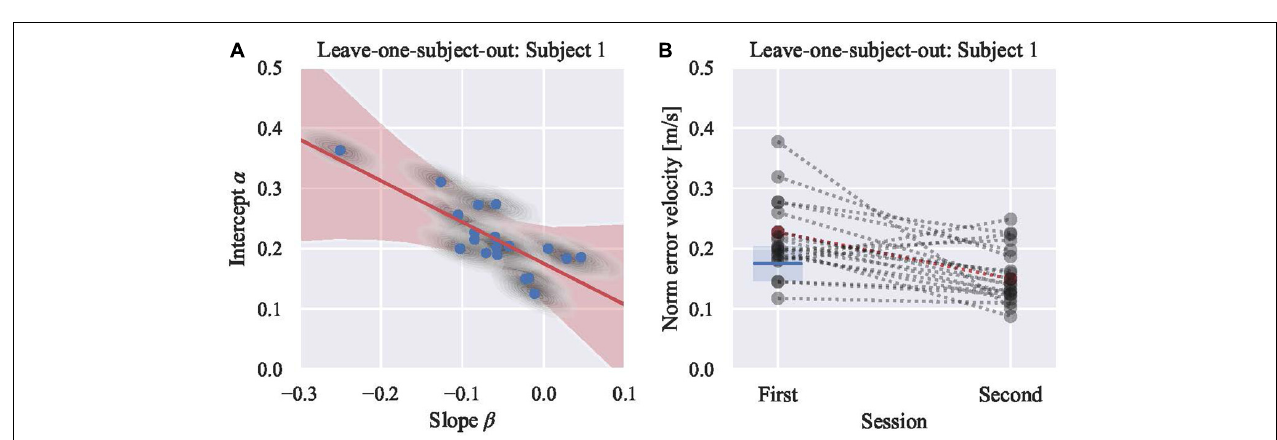
FIGURE 4 | (A) Posterior predictive plot of model 4 using 19 participants’ absolute position errors (leaving subject 1). Each gray shaded area represents multiple samples from the posterior [the intercepts ( α ) and the slopes ( β )] of each subject, and each blue circle shows the average of each area. Red shaded area represents regression lines for all samples, and red line shows their average. The boundary ( γ , the intercept of the red line) is 0.019 m with the credible interval (94%) from 0.017 to 0.021 m. (B) Visualization of classifying results. Subject 1, showing in red marker, is tested. Rest of 19 participants are showing in gray markers. Blue line shows the boundary derived from model 4 in (A) . Blue shaded area shows the 94% credible interval. Mean absolute position error of Subject 1 in the first session was above the boundary. Thus, subject 1 is classified into a group that is expected to improve the performance in the second session. Actual mean absolute position error in the second session is less than that of the first session.